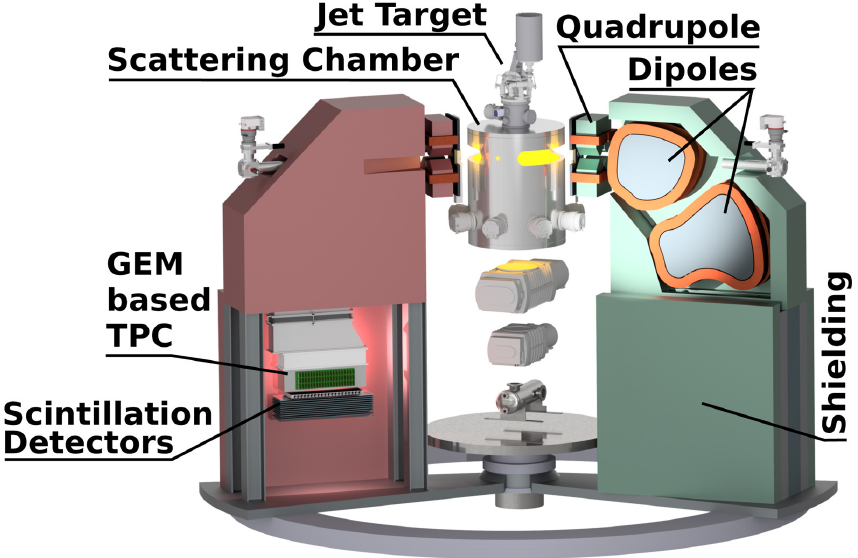
Figure 12. The multi-purpose spectrometer system planned for the MAGIX experiment (figure credit: B. S. Schlimme et al.